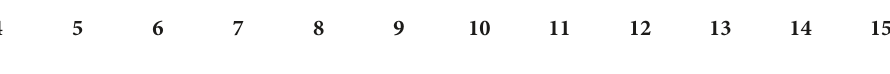
TABLE 7 Correlation between modified Yale Food Addiction Scale 2.0 (mYFAS 2.0) and other variables N =